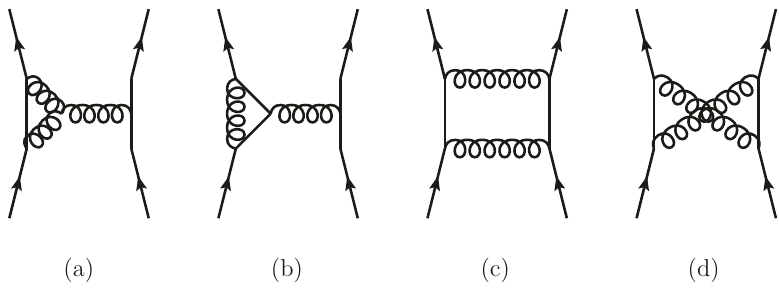
Figure 3 . A few sample one-loop diagrams contributing to quark and gluon scattering at next-to- leading order, in the high-energy limit. Diagrams such as (a) and (b) have the same colour structure of the tree-level diagram, and contribute to the one-Reggeon impact factor. Diagrams such as (c) and (d) introduce colour structures di(cid:11)erent from the colour structure of the tree-level amplitude, and contribute to the two-Reggeon